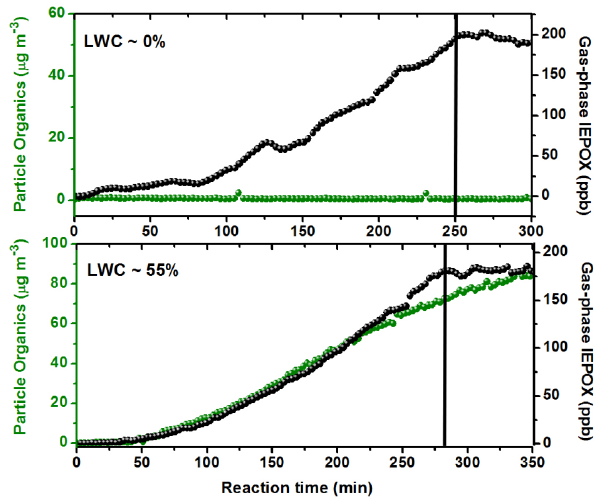
Fig. 1. Typical uptake experiment results as a function of time, shown for trans isomer, at dry (top) and humid (bottom) conditions with the corresponding percent of liquid water content (LWC). The solid black line indicates when IEPOX injection stopped and the mixture was allowed to equilibrate. Double y axes correspond to traces of the same